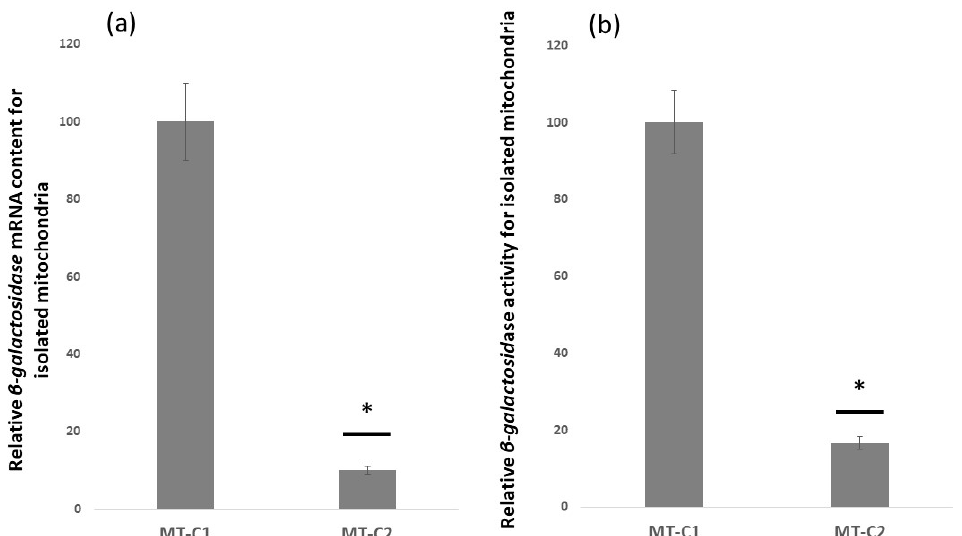
Figure 2. mRNA content and β -galactosidase expression analysis of isolated mitochondria from different yeast strains. ( a ) RT-PCR analysis indicated that in the absence of OXA1 3 ′ -UTR (MT-C2) β -galactosidase mRNA content is signi fi cantly reduced in isolated mitochondria. The values are normalized to that of the MT-C1 construct that carries OXA1 3 ′ -UTR. PGK1 mRNA was used as a control and all values are related to that. ( b ) β -galactosidase activity of isolated mitochondria is highly reduced in the absence of OXA1 3 ′ UTR (MT-C2). Values are normalized to that for MT-C1 set at 100. Each experiment is repeated at least three times. Error bars represent standard deviation. * represents statistically significant results compared to the MT-C1. t -test analysis ( p -value ≤ 0.05) was used to compare di ff erences.